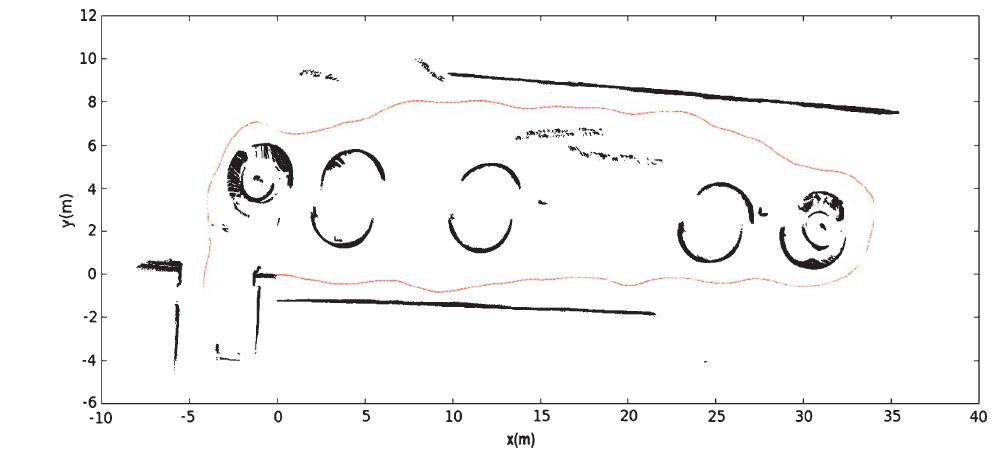
Fig. 10. Path generation from autonomous navigation (thinner line), and LIDAR based mapping (dotted lines) results from infering x t and x t + 1